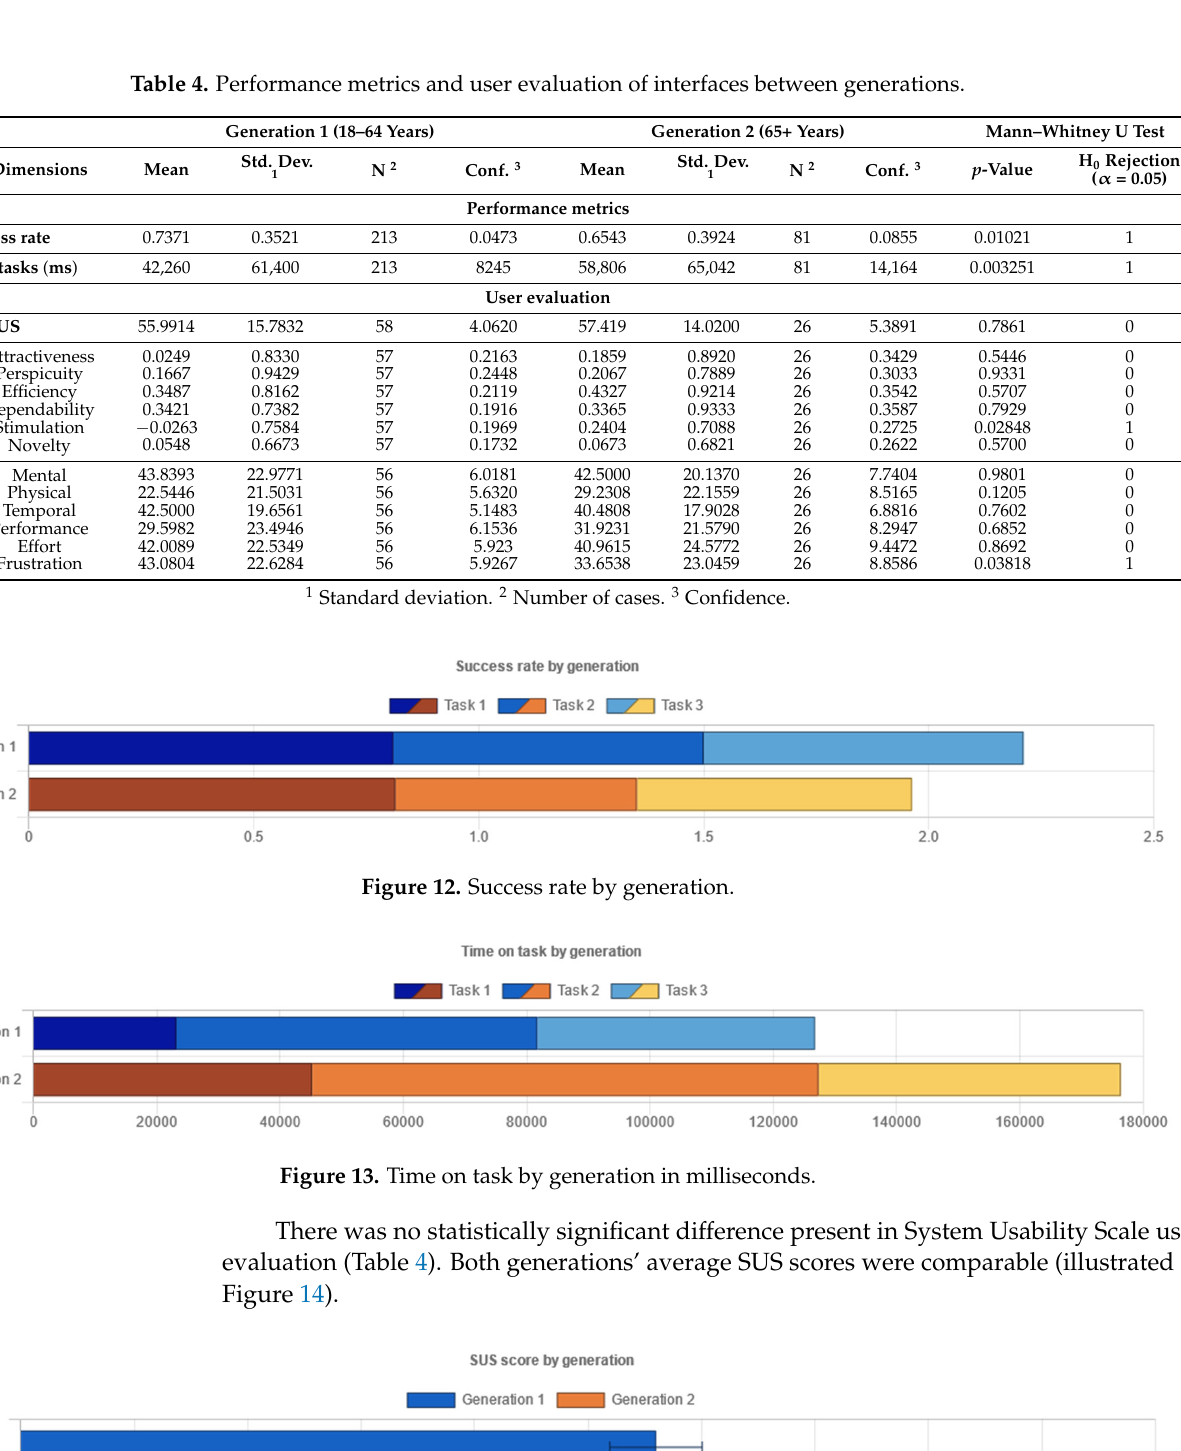
Figure 15. UEQ dimensions by generation.